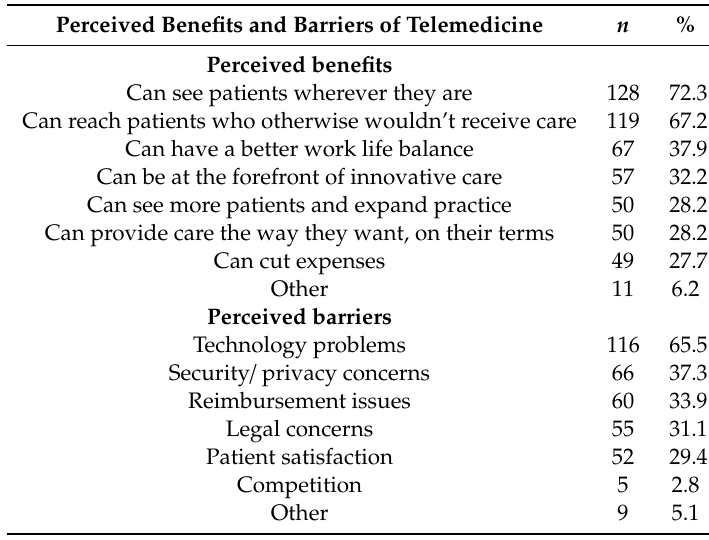
Table 3. Perceived benefits and barriers of telemedicine in clinical practice, N =